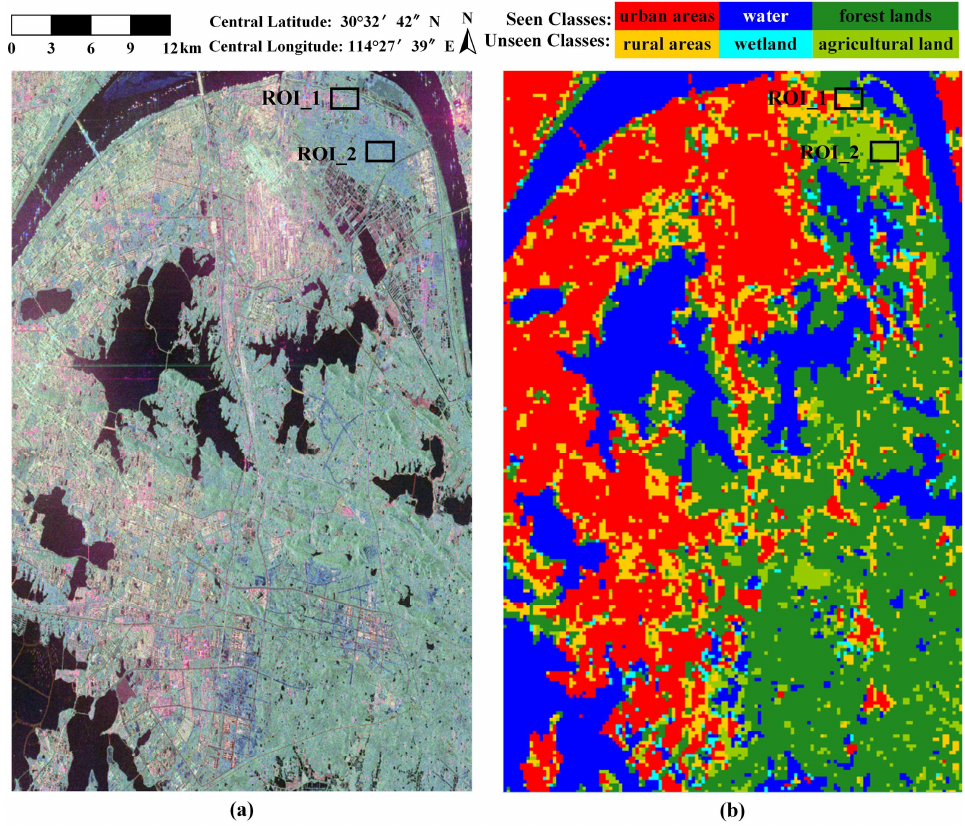
Figure 8. The Wuhan Data2 and the GZSL classification results. ( a ) Pauli RGB image of Wuhan Data2, and ( b ) the GZSL result with the Word2Vec attributes applied.